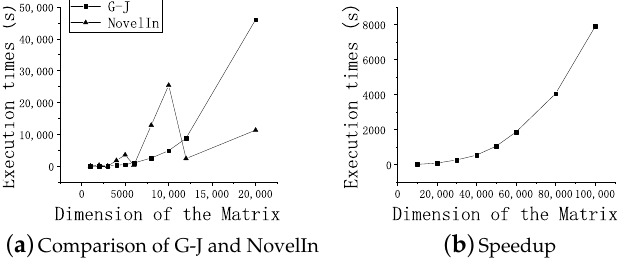
Figure 5. The comparison of G-J and NovelIn and NovelIn’s performance on GF ( 2 32 )